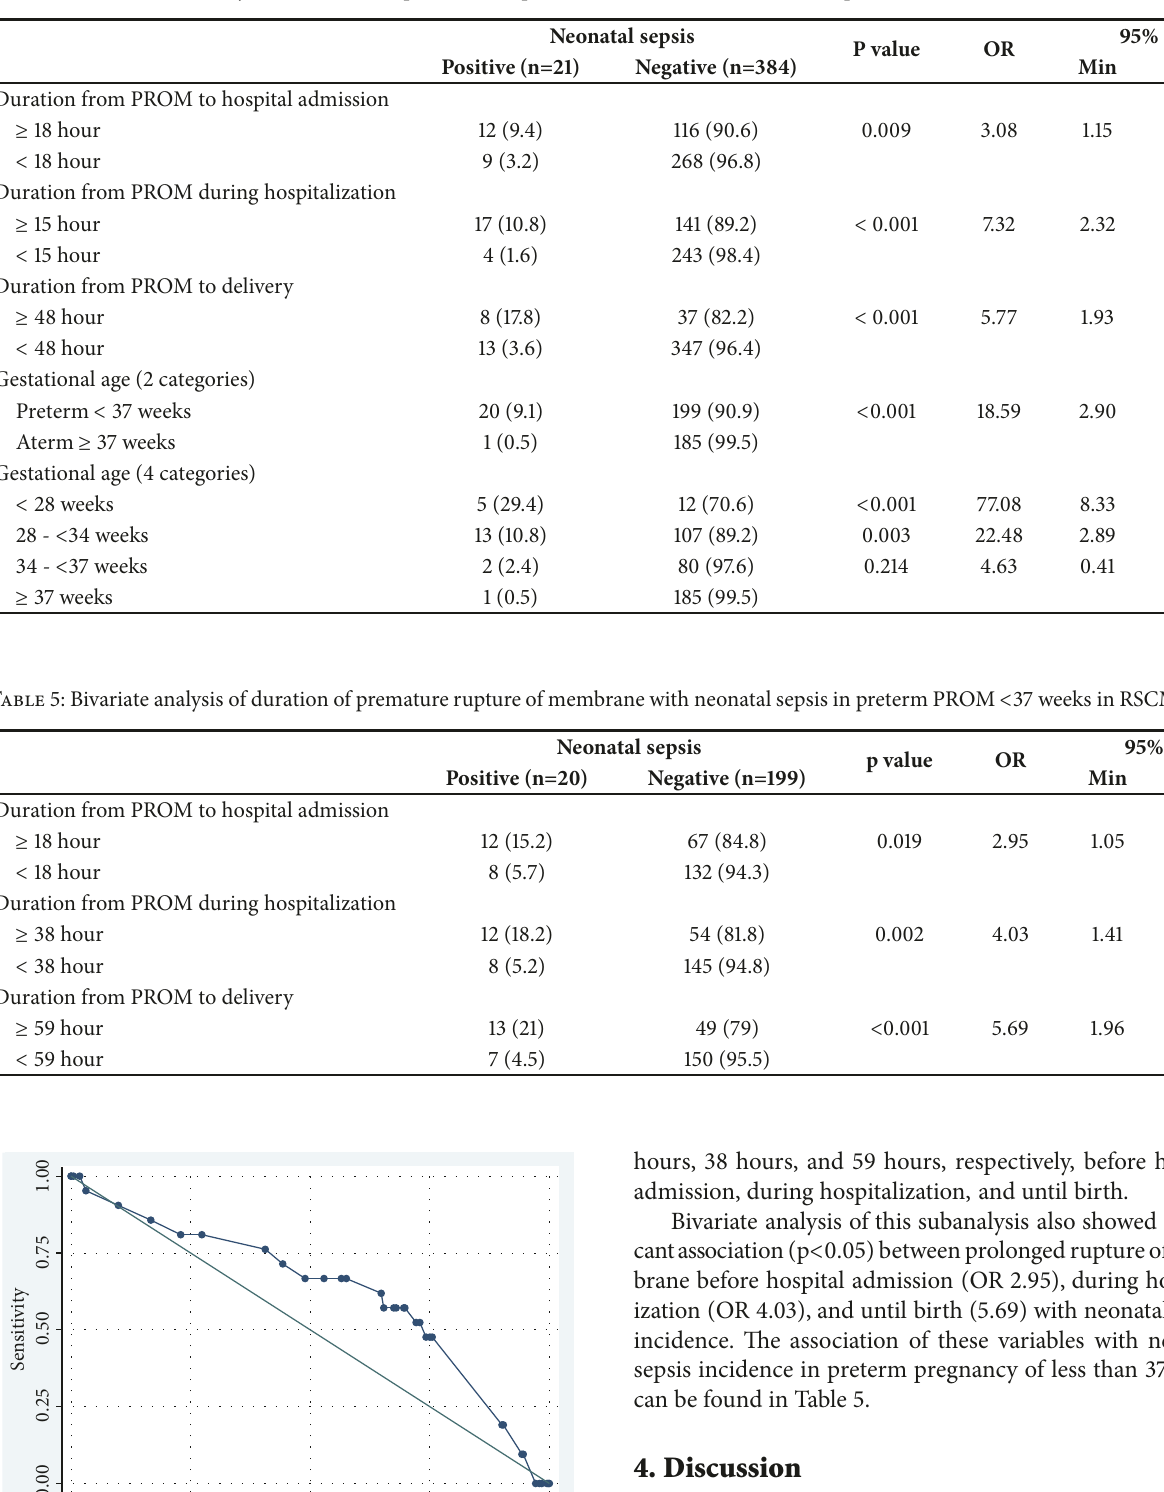
Table 4: Bivariate analysis of duration of premature rupture of membrane with neonatal sepsis in all PROM cases in RSCM, 2016.